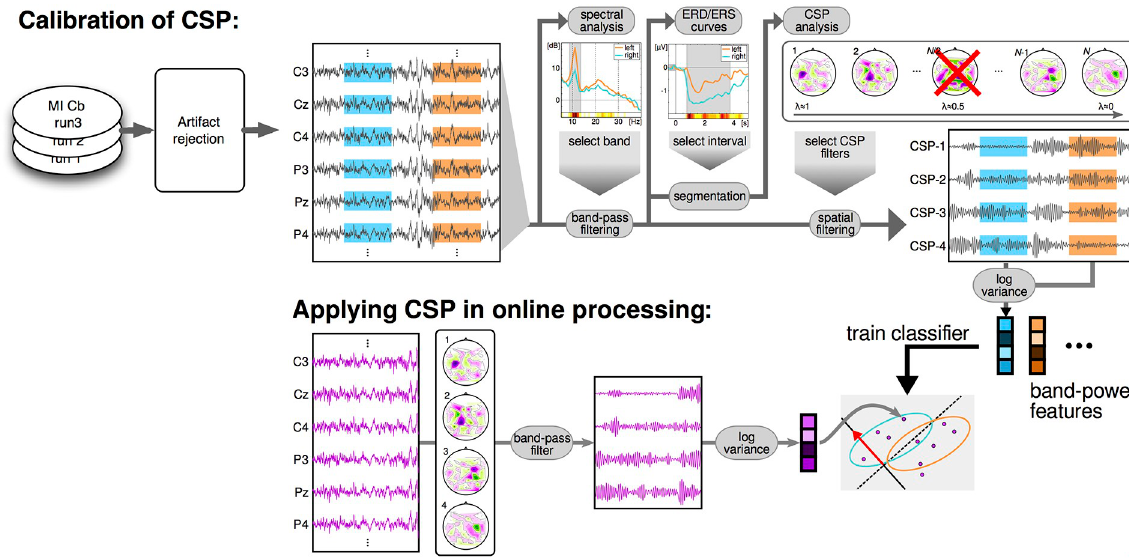
Fig 2. Dataflow of the processing applied during the BCI session. Once the MI-Cb data are collected, artifact rejection and heuristic for the selection of subject-specific frequency band and time interval are applied. CSP filters are then calculated by cross-validation, and a linear classifier is trained on the log-variance features of the CSP filtered data. The same frequency band, CSP filters and classifier, are then applied in real-time during the feedback session to provide the visual feedback to the user. The classification is applied during the whole trial, i.e. the subject-specific time interval is not used during the online